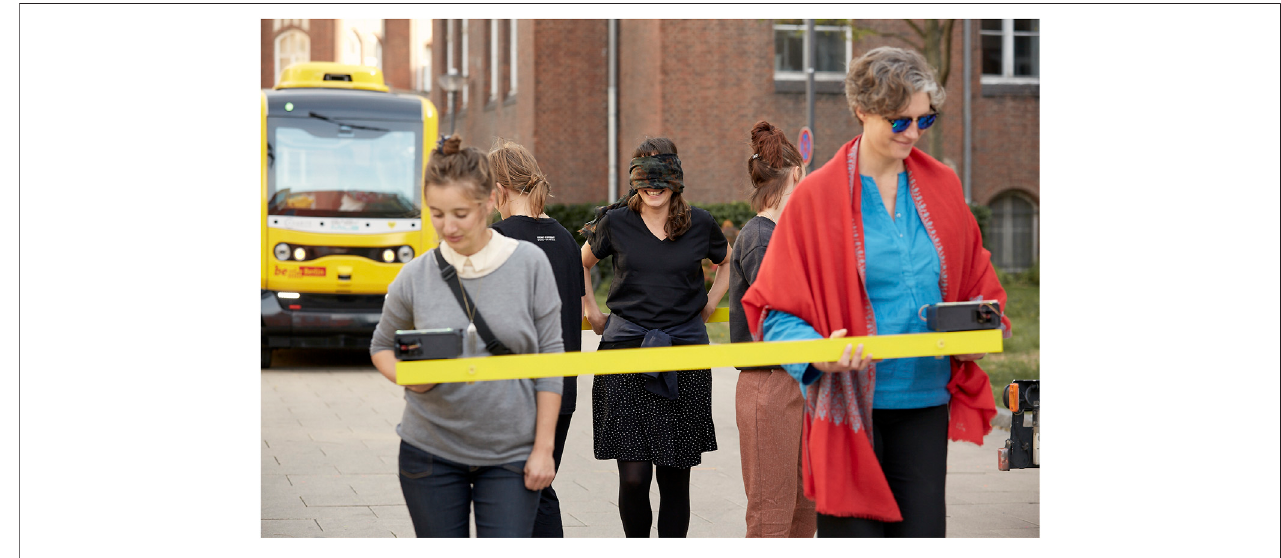
FIGURE 1 | Toy bus with players.